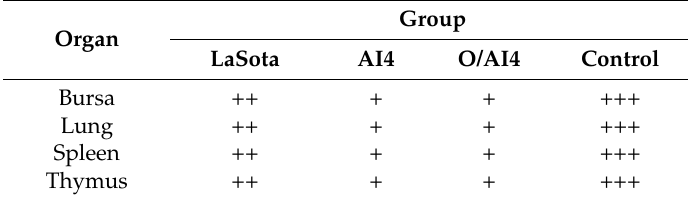
Table 3. Distribution and intensity of histological lesions.